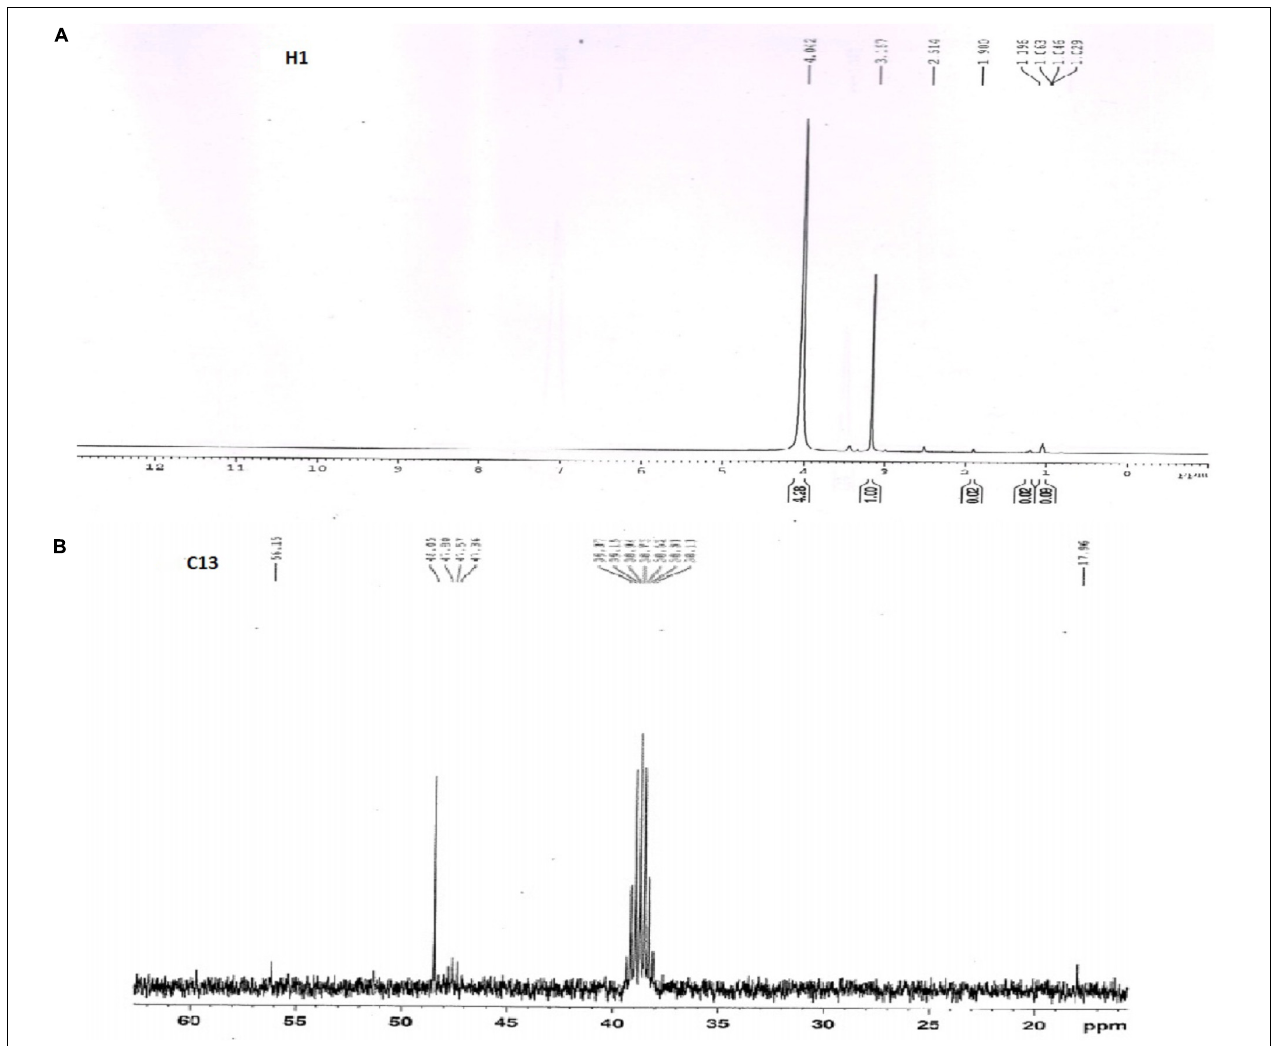
FIGURE 8 | 1 H and 13 C NMR spectra for extracted biosurfactant. (A) 1 H spectra showed glyceride, ester group and acyl moieties, (B) 13 C spectra represents primary alkyl